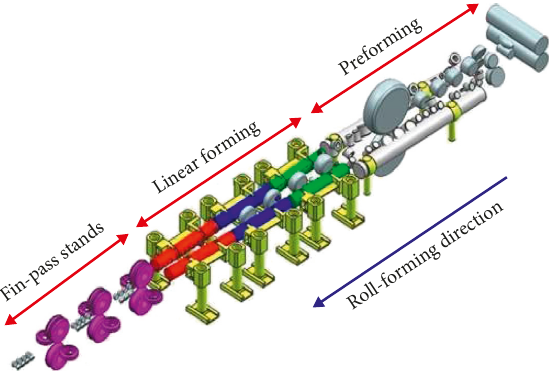
Figure 1: Schematic diagram of roll